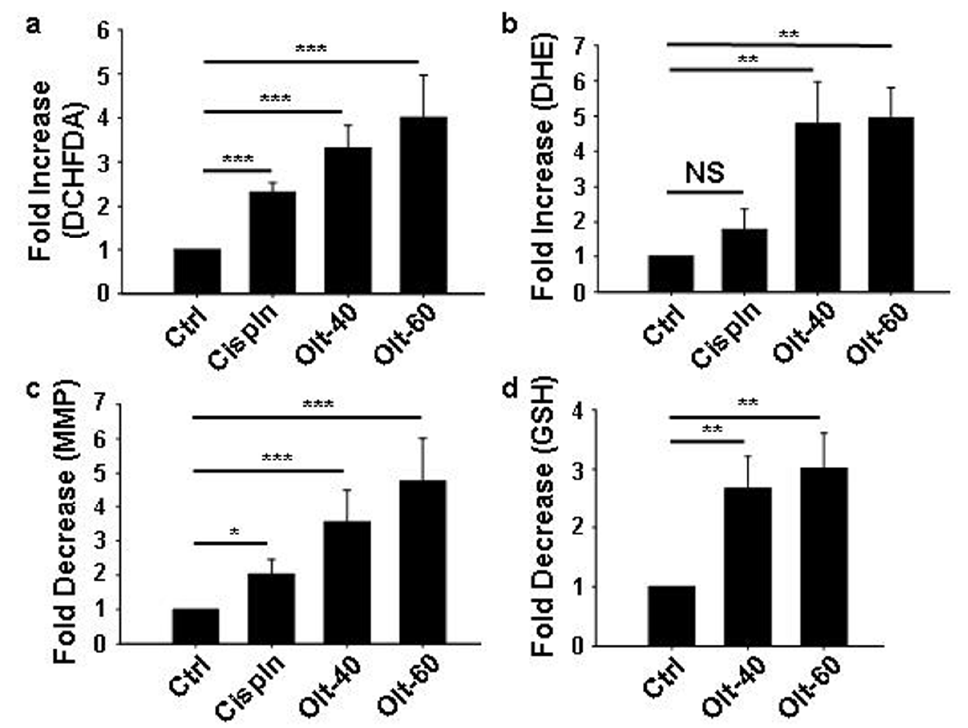
Figure 3. Influence of Olt on ROS and mitochondrial membrane potential: ( a , b ) Flow cytometry quantification of DCHFDA + and DHE + U-87 MG cells representing ROS-high state, following their exposure to Cispln and two different concentrations of Olt (40-, and 60 µ M). The data shows the fold increase in ROS in Cispln- and Olt-treated cells compared to untreated Ctrl. ( c ) Flow cytometry detection of loss of MMP by Rhodamine-123 staining. The data shown represent the fold difference in MMP loss in Cispln- and Olt-treated cells compared to untreated Ctrl. ( d ) Flow cytometry quantification of GSH reveals an Olt-mediated decrease in glutathione levels following Olt exposure of U-87 MG cells for 48 h. Data shown represents the fold decrease in glutathione levels in the Olt-treated cells compared to untreated Ctrl. Data are presented as mean ± SEM (n = 4–8). * p ≤ 0.05; ** p ≤ 0.01; *** p ≤ 0.001.